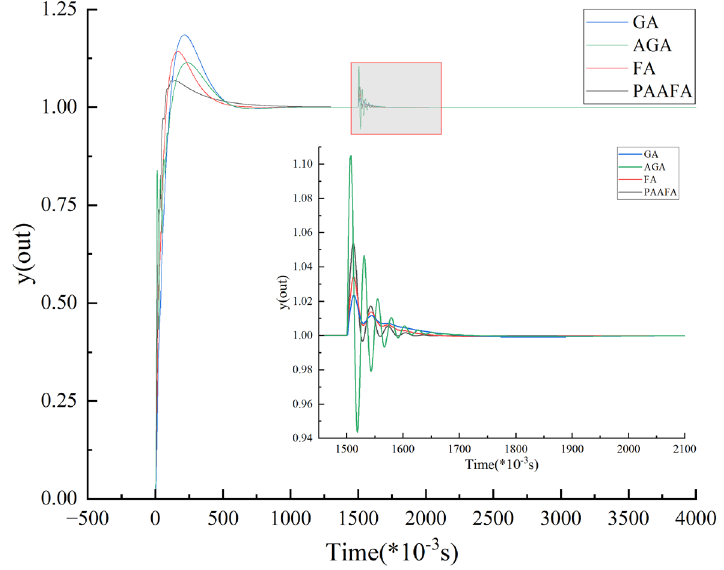
Figure 7. Unit step response under unit step disturbance.